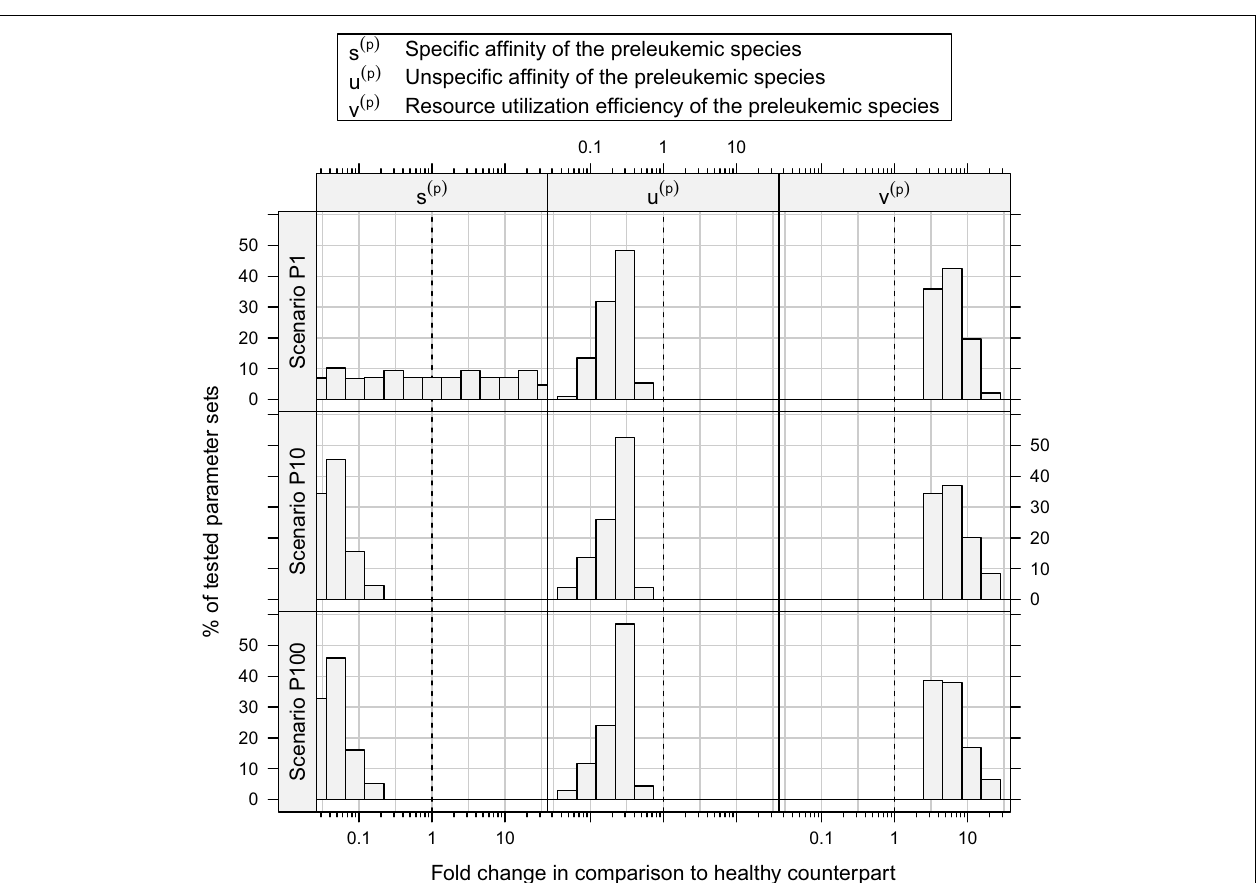
consistent parameter sets. s ( p ) is decreased in all consistent parameter sets of scenario P10 and P100, while it is indifferent in scenario P1. u ( p ) is decreased and v ( p ) is increased in all consistent parameter